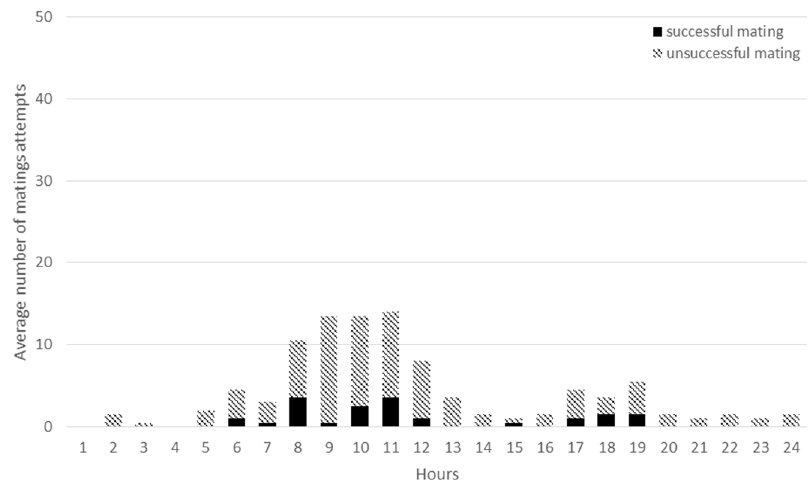
Figure 8. The daily distribution of successful matings (dark column parts) and unsuccessful mating attempts (light column parts) in HET groups.